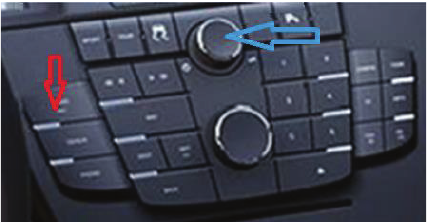
Figure 5: The radio used in the radio task. Red arrow points to the correct button for turning the radio on. Blue arrow shows where the participants tried first to start the